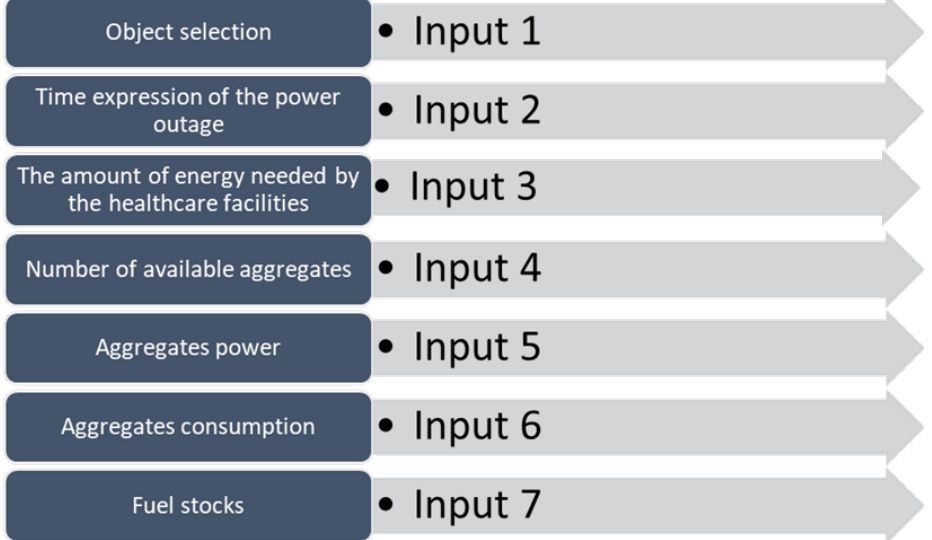
Figure 2. Algorithm inputs